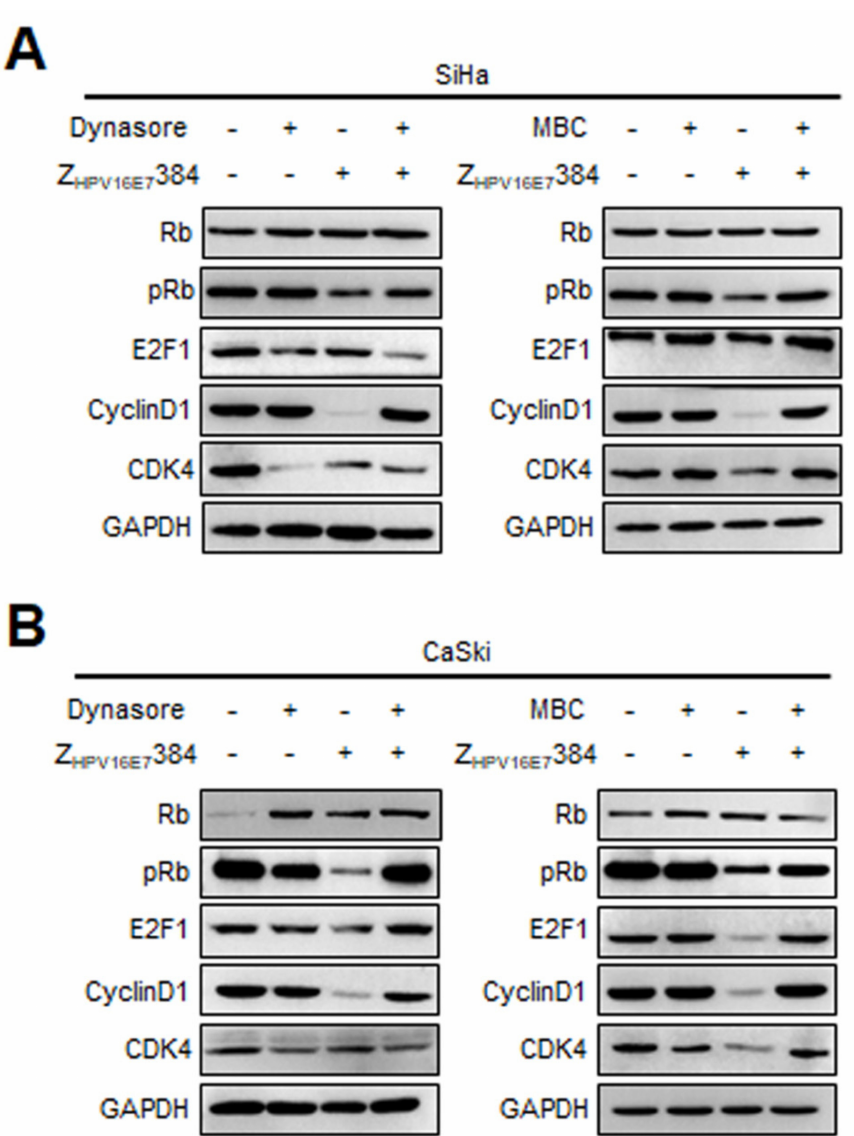
Figure 8. Dynasore and MBC reversed the effect of Z HPV16E7 384 on cell cycle-related proteins. ( A ) The SiHa and ( B ) CaSki cells were respectively pre-treated with Dynasore and MBC and then incubated with Z HPV16E7 384. The cell cycle-related proteins were then analyzed by Western blot. The SiHa and CaSki cells only treated with PBS, the inhibitors, or Z HPV16E7 384 were used as the